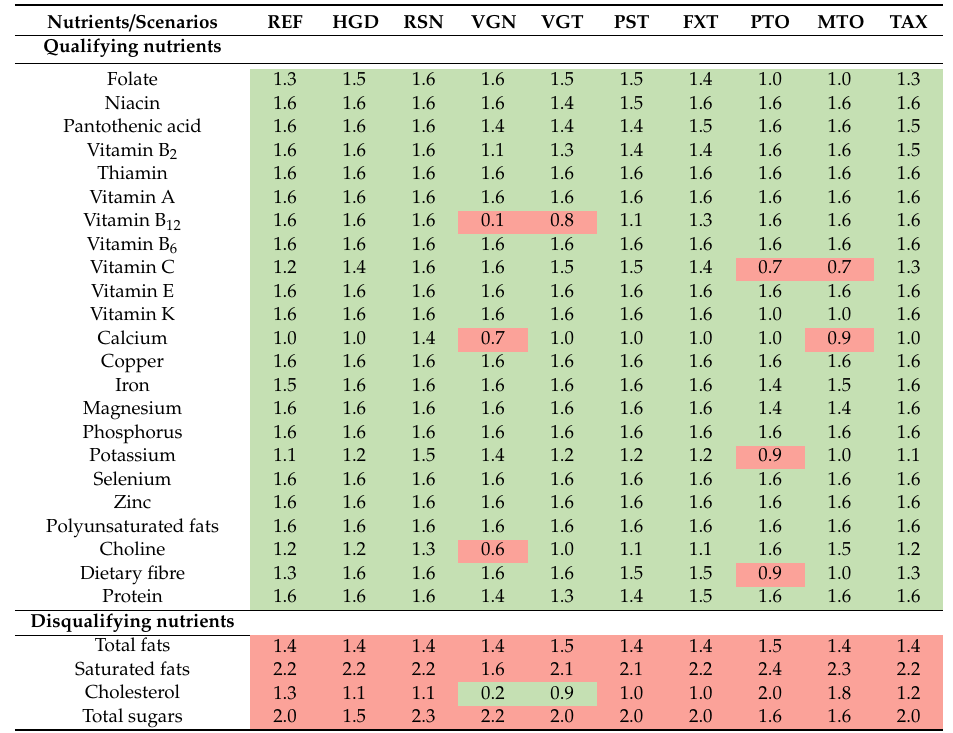
Table 3. The ratio of daily nutrient intake amounts and their daily recommended levels under the current Swiss diet (REF) and nine alternative dietary